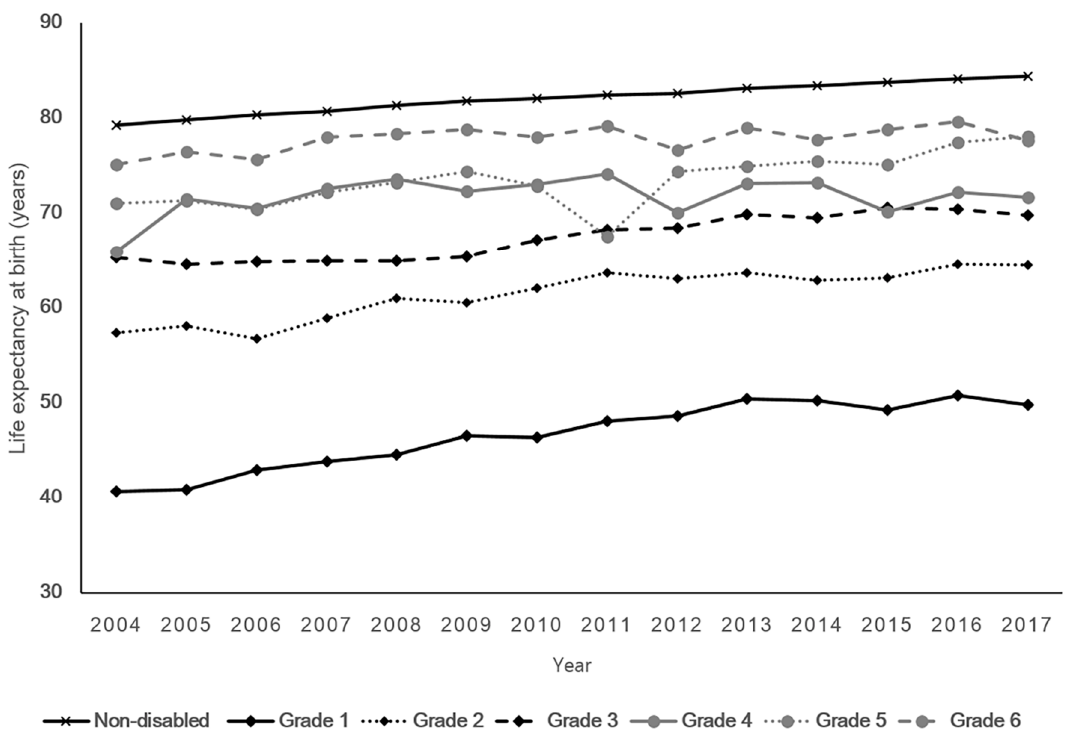
Figure 1. Life expectancy trends between 2004 and 2017 among non-disabled and registered disabled people according to their disability grade.